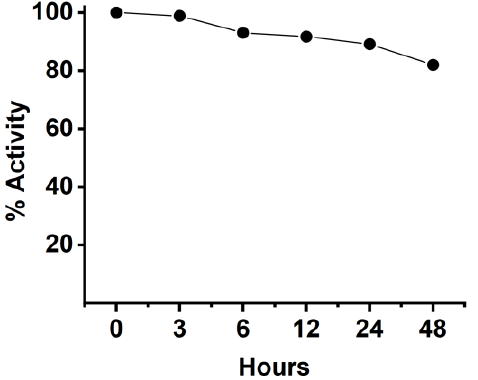
Figure 10. The stability of BsNb was tested by mixing the BsNb with human serum and incubated for different times, then evaluating the changes in its binding activity to CD20 by ELISA. After mixing 2 μg of anti-CD20/CD3 BsNb with human serum, the mixture was determined at different time points after incubation at 37 °C. The mixed BsNbs were used as the primary antibody, and HRP-conjugated 6 × His-tagged mouse monoclonal antibody was used as the secondary antibody to detect the binding activity to CD20 antigen.